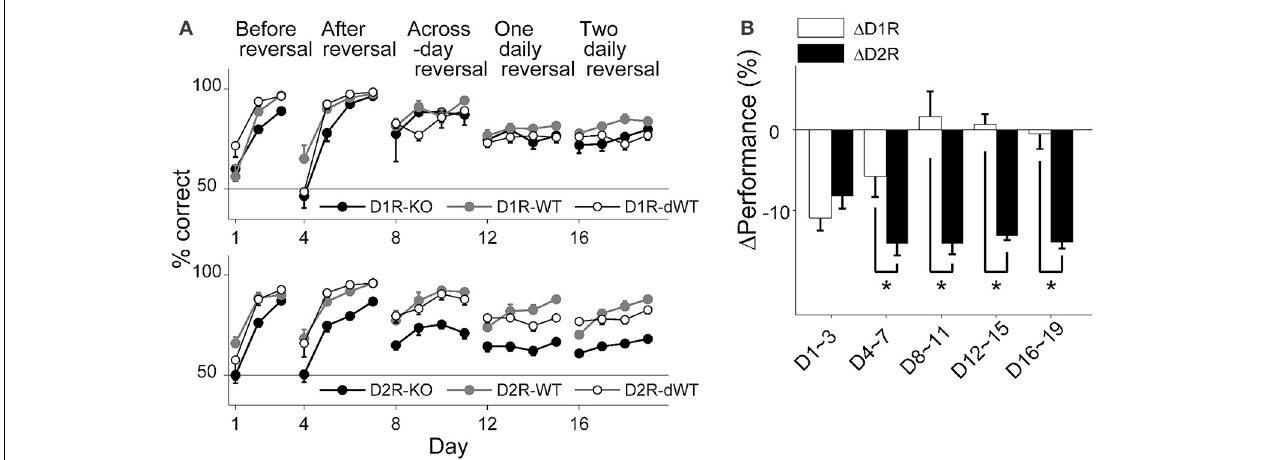
FIGURE 2 | Behavioral performance in the reversal task. (A) Behavioral performance (% correct choice; mean ± s.e.m. across animals) is shown for each daily session for each experimental group. (B) Relative performance